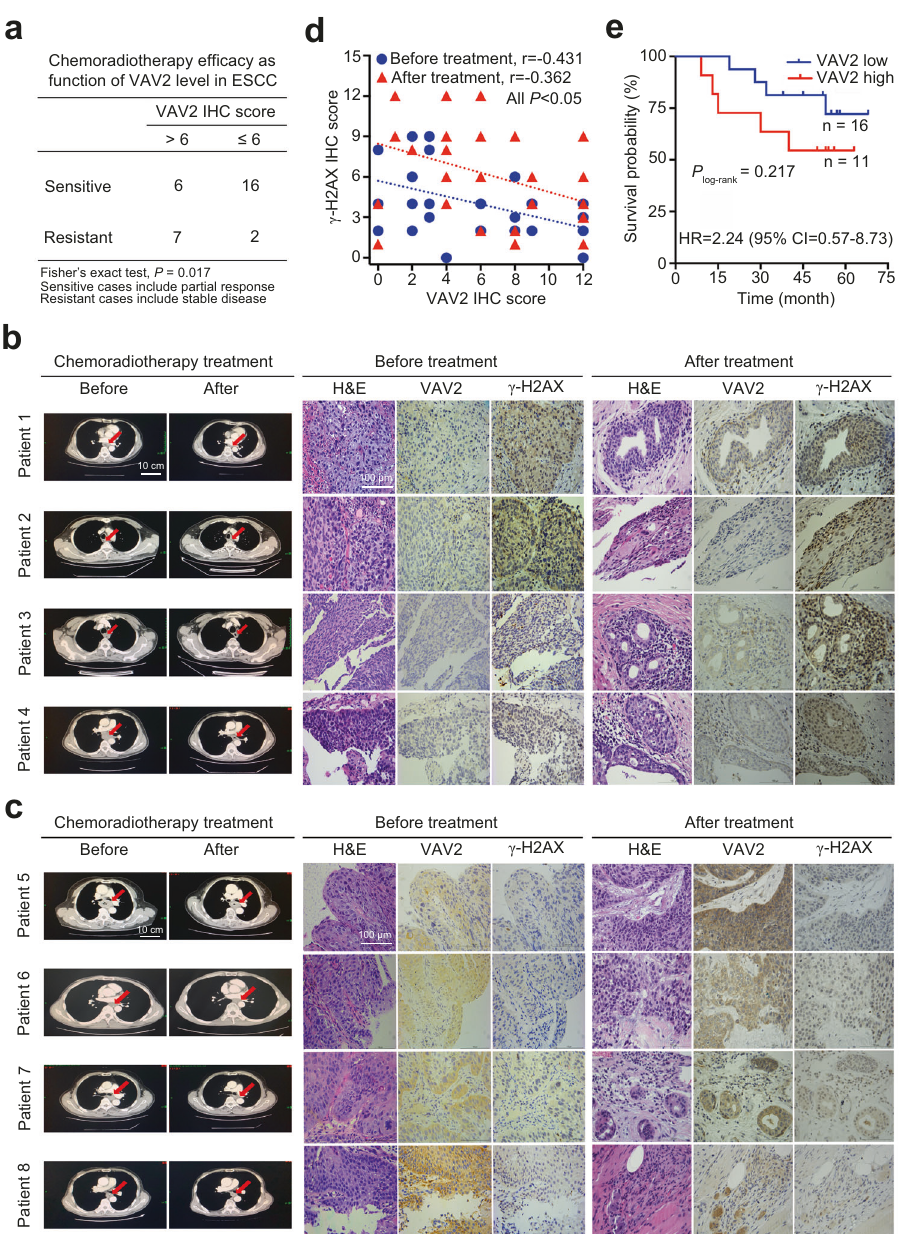
Fig. 6 VAV2 predicts radiotherapy vulnerability of ESCC. a Chemoradiotherapy ef fi cacy in patients with ESCC ( n = 31) as function of the VAV2 level in tumor samples detected by immunohistochemical (IHC) staining, showing ESCC having IHC score >6 were signi fi cantly more resistant to the therapy compared with ESCC having the score ≤ 6. b – d Correlation between the VAV2 and γ -H2AX levels in ESCC tumors before and after chemoradiotherapy. Images show computed tomography of tumors before and after treatment ( left ) and H&E, VAV2 and γ -H2AX IHC staining in tumors before ( middle ) and after ( right ) treatment in ESCC sensitive ( b ) or resistant ( c ) to chemoradiotherapy. Scale bars, 100 µm. d Shown are the Spearman correlations between VAV2 and γ -H2AX levels in tumors before and after treatment. e Kaplan – Meier curves of patient survival according to VAV2 level in ESCC tumor. VAV2 high, IHC score > 6; VAV2 low, IHC score ≤ 6. Also present with the Kaplan – Meier curves is the hazard ratio (HR) and 95% con fi dence interval (CI) from multivariate Cox proportional hazard models, including age, sex, tumor stage as covariates. Four of 31 patients lost follow-up and thus were excluded in the